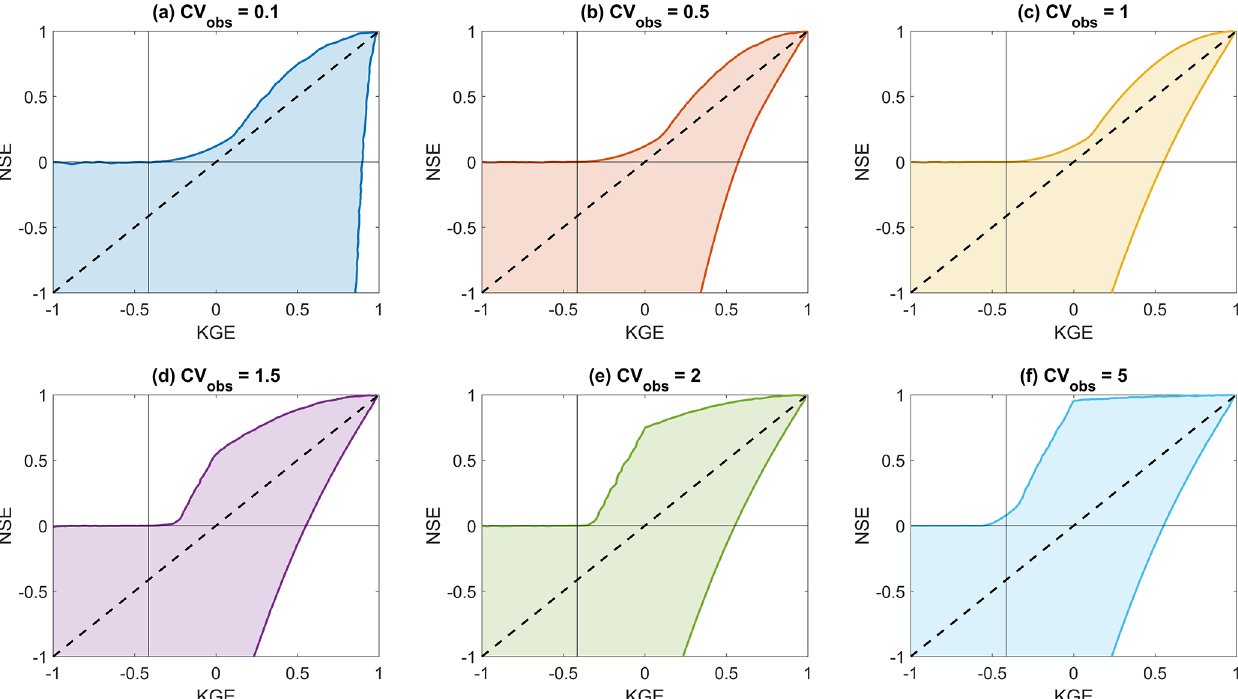
Figure A1. Correspondence between synthetic KGE and NSE values based on 1 × 10 6 random samples of components r , a and b , for different coefficients of variation (CVs). Colour coding corresponds to the colours used in Fig.